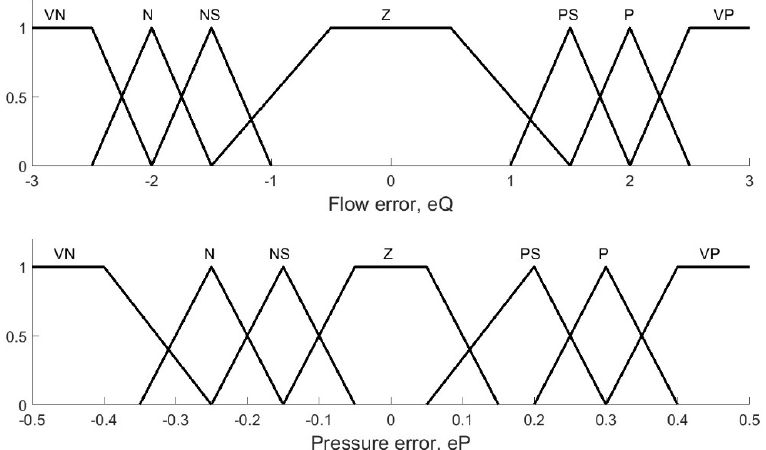
Figure 9. Linguistic values assigned to the controller inputs.